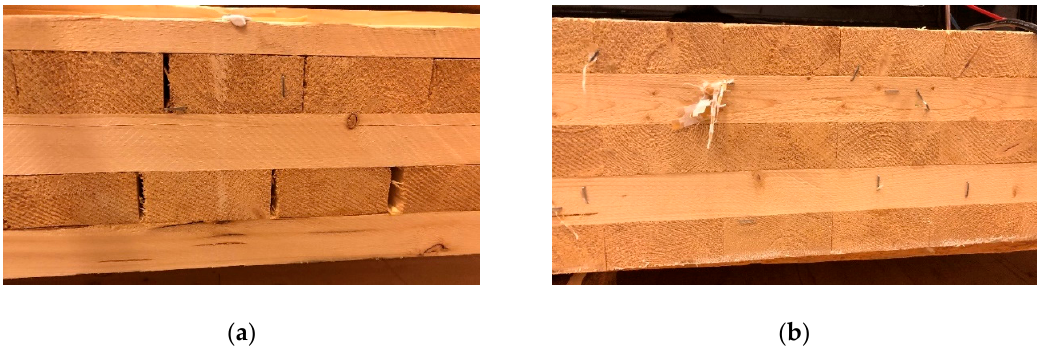
Figure 13. Measured (blue) and simulated (red) FRFs at point 11, 13, 17, and 24.